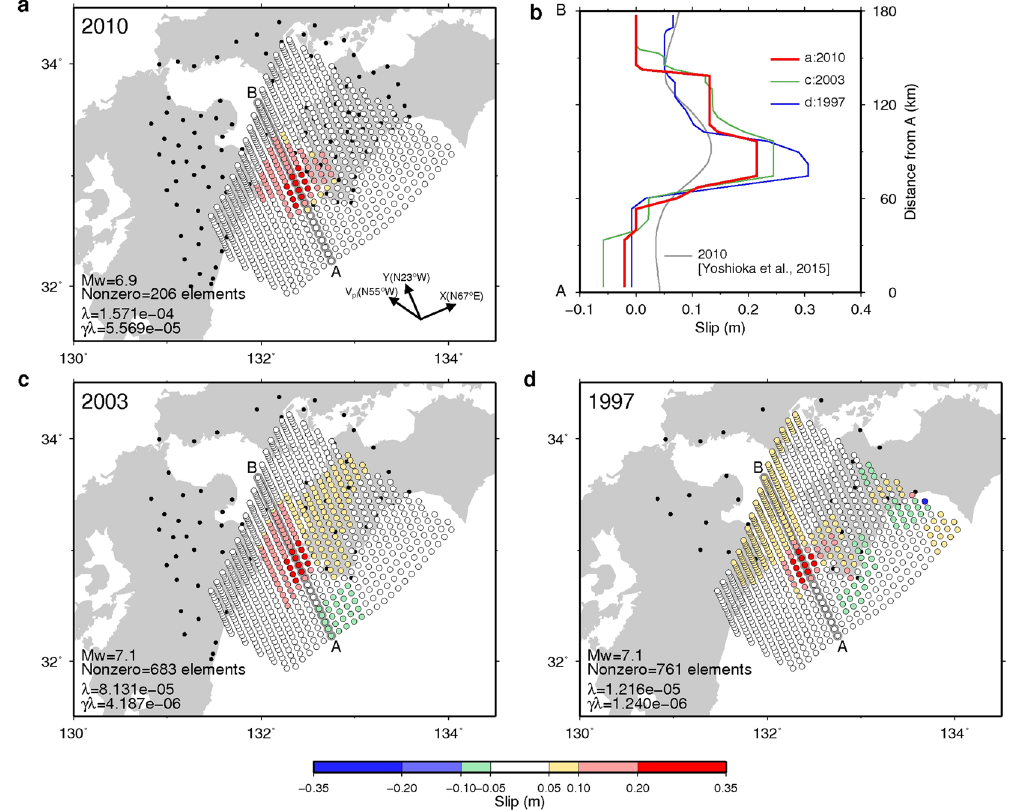
Figure 2. ( a ) Estimated slip distribution in the dip direction in the X – Y plane for the 2010 event. Black dots indicate GEONET stations. ( b ) Slip distribution along line AB. Blue, green, and red represent the 1997, 2003, and 2010 events, respectively. Grey line represents the 2010 event estimated by smoothed inversion 12 . ( c ) Estimated slip distribution in the X – Y plane for the 2003 event. ( d ) Estimated slip distribution for the 1997 event. The maps and graph are created by Generic Mapping Tools software (GMT v4.5.12; http://gmt.soest. hawaii.edu/) 33